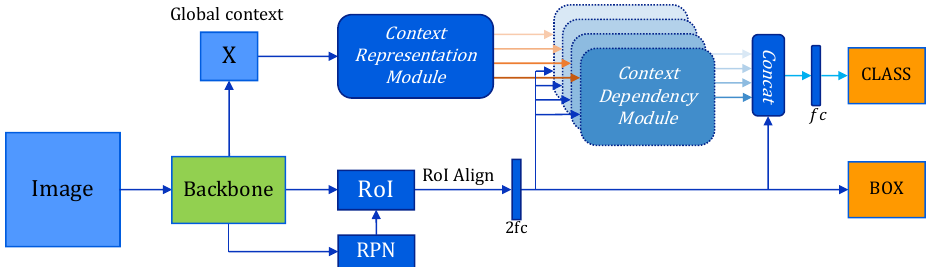
Figure 2. An overview of our Global Contextual Dependency Network